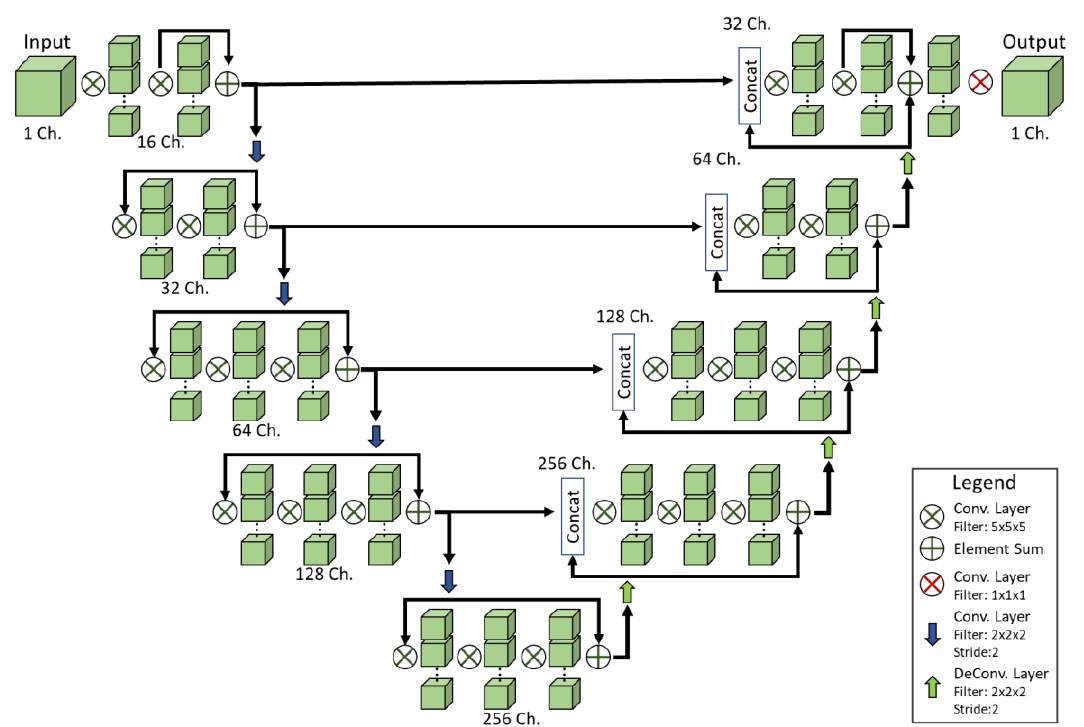
Figure 4. Network structure. The V-Net consists of an encoder/decoder configuration connected by skip connections. Volumetric image patches are processed with 3D convolution kernels. The number of feature maps (channels) at each stage increases with the depth of the network. Convolution layers consist of convolution followed by batch normalization and activation via PReLU. The output of the network is a probability map with floating point values [0,1] and the same dimensions as the input.